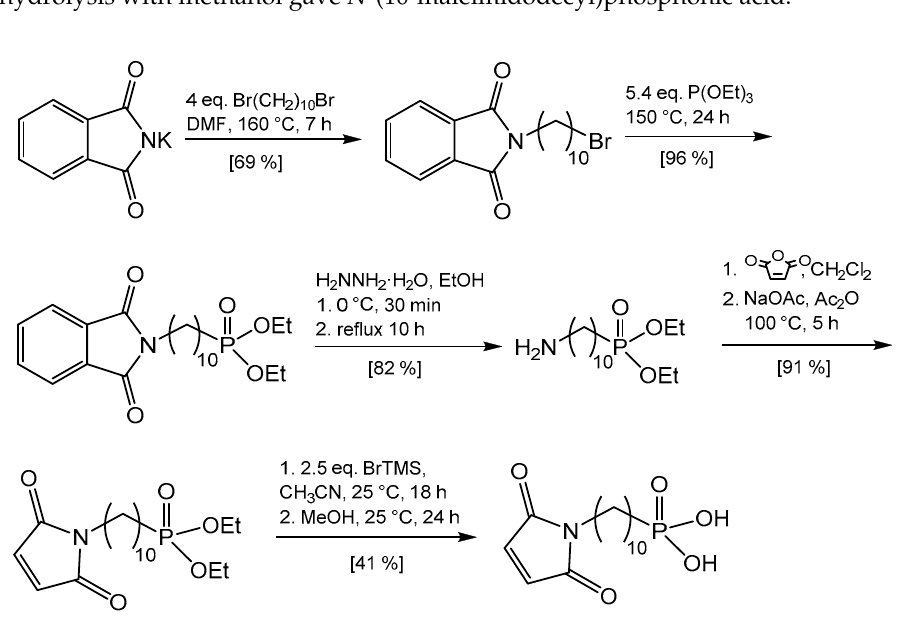
Figure 3. Synthesis of the maleimide phosphonate coupling agent.